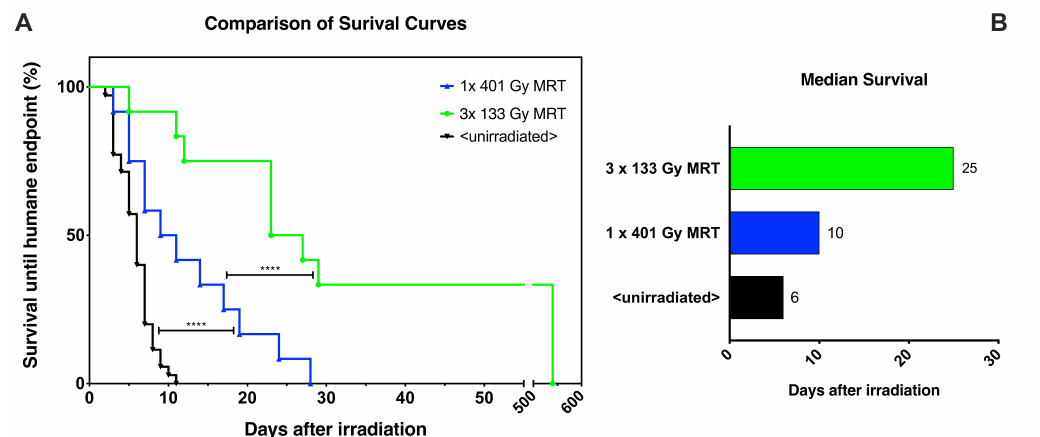
Figure 3. Analysis of animal survival after treatments. ( A ) Comparison of survival between the single (1 401.23 Gy peak dose), the triple fraction (3 133.41 Gy peak-dose) of MRT, and re-used data × × of unirradiated melanomas ( n = 35) from our previous published experiment ( < unirradiated > ) [3]. Survival was defined as the time elapsed between the irradiation until the humane endpoints were reached. The di ff erences were significant for the Gehan–Breslow–Wilcoxon test, which gives extra weight to the early timepoint: Chi-Square X 2 (df = 2, n = 59) = 24.35, and p < 0.001. ( B ) Median survival. The median survival for the fractionated group is 23 days regardless of whether the mice showing tumour ablation are included in the calculation. Significant values of four orders of magnitude are represented with